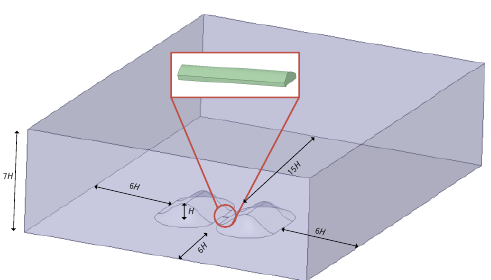
Figure 4. Layout of the model and size of the fluid domain size.